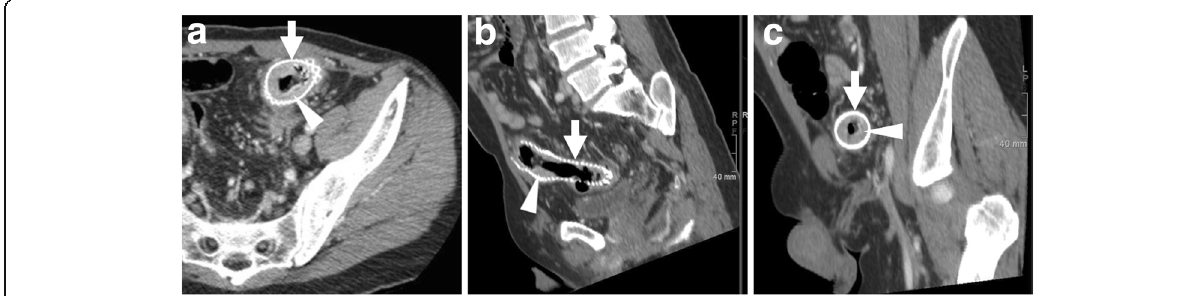
Fig. 18 Tumour ingrowth causing stent malfunctioning. In the same patient, compared to initial MRI (Fig. 5), focused multiplanar reconstructions ( a - c ) of follow-up CT showed enhancing neoplastic tissue (arrowheads) growing within the SEMS (thick arrows), leading to recurrent